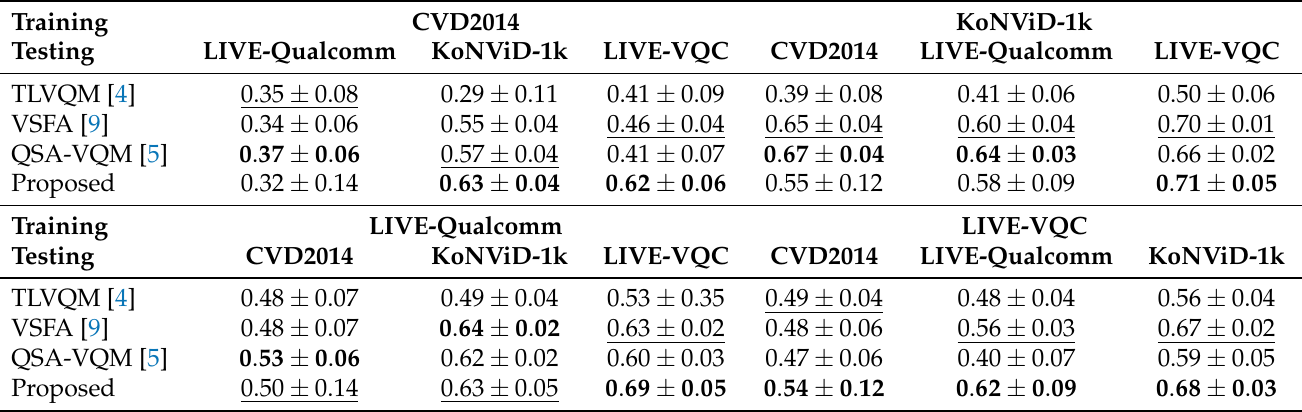
Table 3. SROCC in the Cross-dataset setup. In each column, the best and second-best values are marked in boldface and underlined,